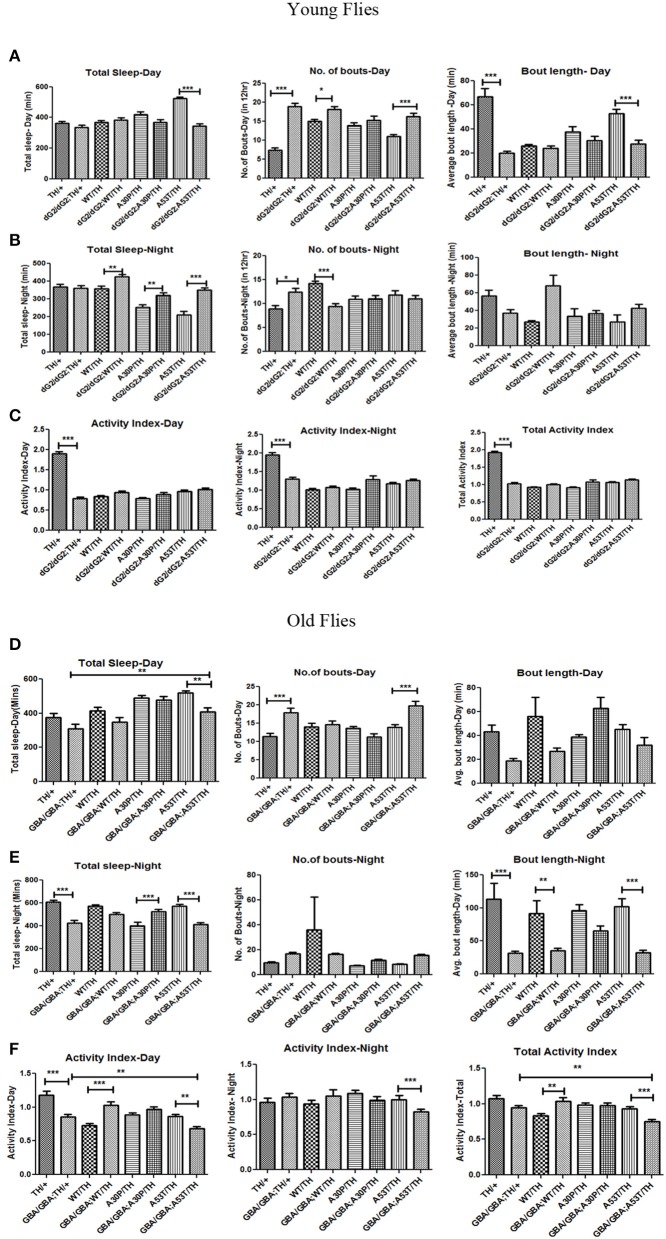
Sleep Behavior in dG2/dG2 GBA RNAi flies expressing wildtype and mutant α-synuclein. Sleep behavior in young flies (0–3days) with and without dG2/dG2 silencing, expressing wildtype (WT), A30P and A53T mutant synuclein using TH-Gal4 is represented as total length of sleep, fragmentation in sleep indicated by sleep bout number, and the average length of sleep in 12 h light (Day) and 12 h dark (Night) cycles (A,B). Activity index represents fly activity level during the wake periods in day, night and in total (C). GBA silenced A53T old flies showed pathogenic symptoms such as increased daytime sleep, with an increased number of bouts (D) and a decreased night sleep with decreased night bout length (E). These flies also show marked reduction in wake activity during day, night and in total (F). Bars represent mean values of at least three independent experiments ± the standard error of the mean from 16 flies that were individually recorded in each experiment conducted using drosophila activity monitor. Differences in means were compared by one-way ANOVA followed by the Newman-Keuls Multiple Comparison post hoc test (between TH/+ vs. dG2/dG2;TH/+, dG2/dG2 vs. dG2/dG2;WT/TH, dG2/dG2; A30P/TH and dG2/dG2;A53T and WT/TH vs. dG2/dG2;WT/TH and A30P vs. dG2/dG2;A30P/TH and A53T vs. dG2/dG2;A53T/TH). *** represents p < 0.0001, **p < 0.001, and *p < 0.05.